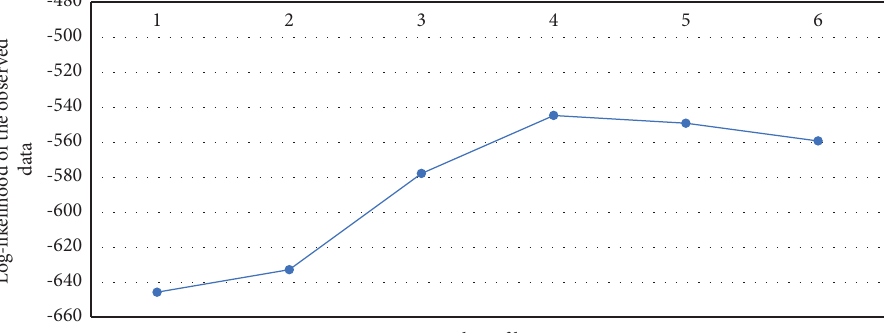
Figure 13: Te log-likelihood of trajectory distribution under diferent numbers of